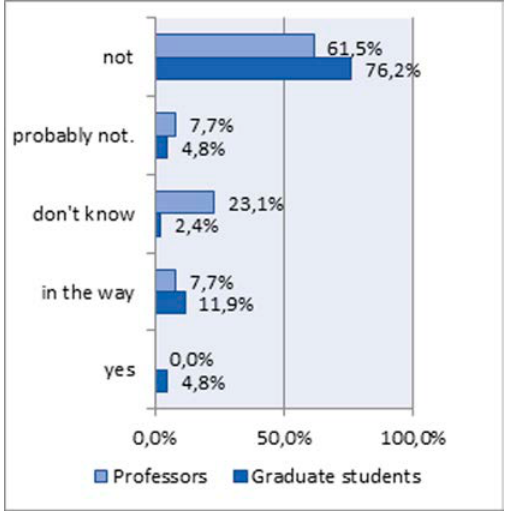
Fig. 3. Respondents' opinions on whether the achieved results are consistent with the goals set by the